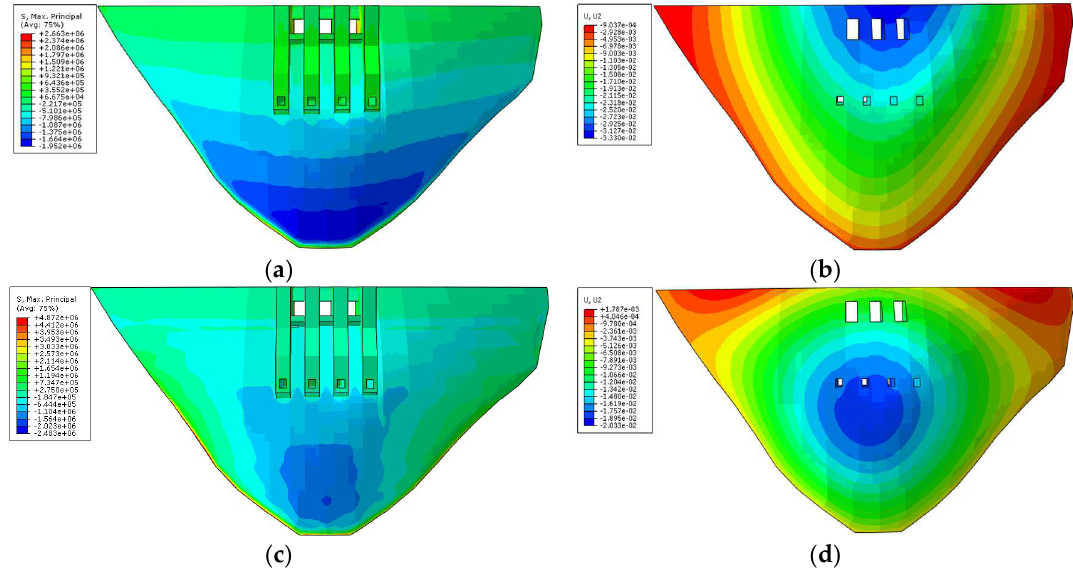
Figure 7. The first principal stress and the displacement along the river direction distribution under analysis cases 1 & 10. ( a ) The first principal stress distribution under analysis case 1 (Unit: Pa); ( b ) the displacement along the river distribution under analysis case 1 (Unit: mm); ( c ) the first principal stress distribution under analysis case 10 (Unit: Pa); ( d ) the displacement along the river distribution under analysis case 10 (Unit: mm). Table 4. Characteristic stresses at different key locations under analysis cases 1 & 10 (unit: MPa). Location